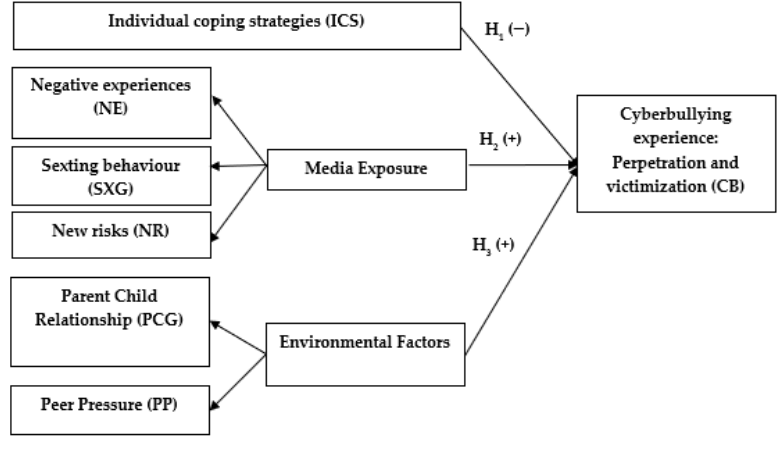
Figure 1. Research model.